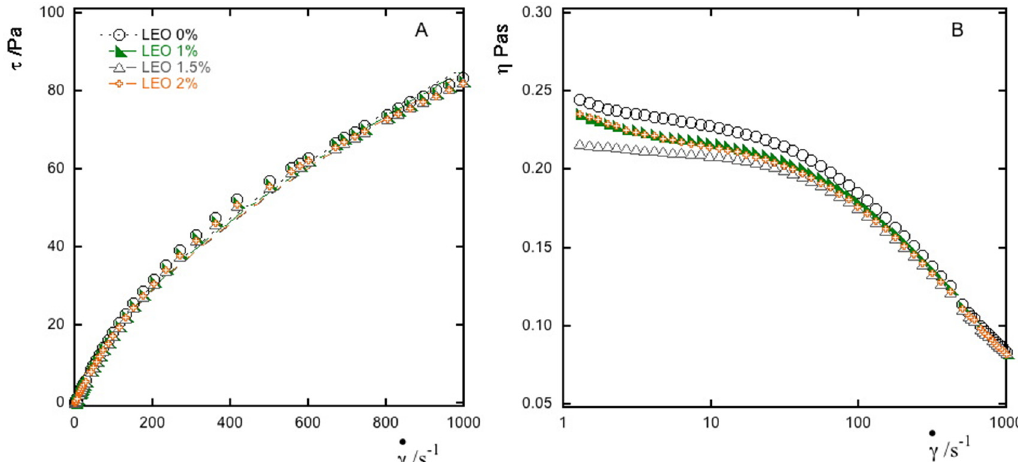
Figure 2. Flow curve ( A ) and apparent viscosity curve ( B ) of alginate nanoformulations at different concentration of LEO (0%-empty circle, 1%-green triangle, 1.5%-empty triangle, 2%-orange cross) stabilized by Tween 80 (1% w / w ).